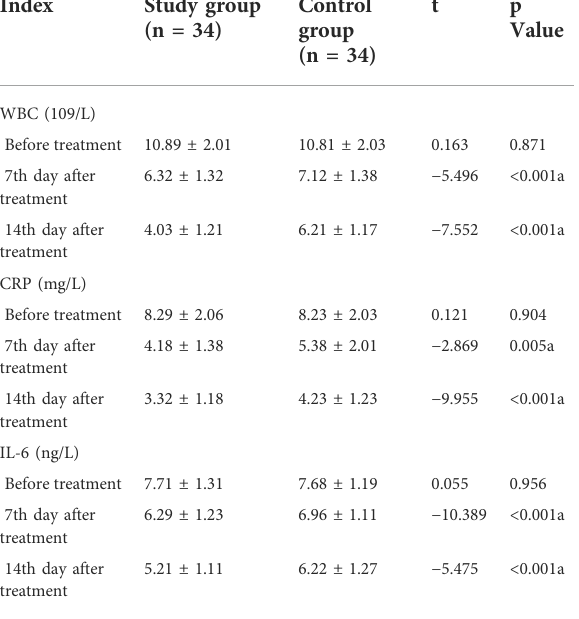
TABLE 4 Comparison of in fl ammatory indexes between the two groups (Mean ± Standard Deviation).